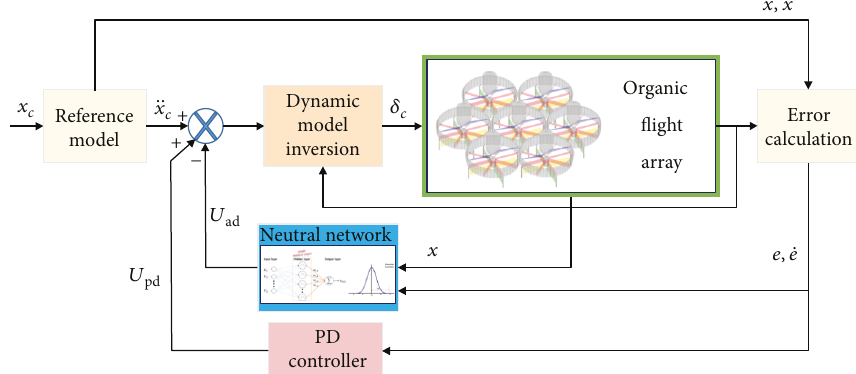
Figure 6: Controller structure of the adaptive neural network.